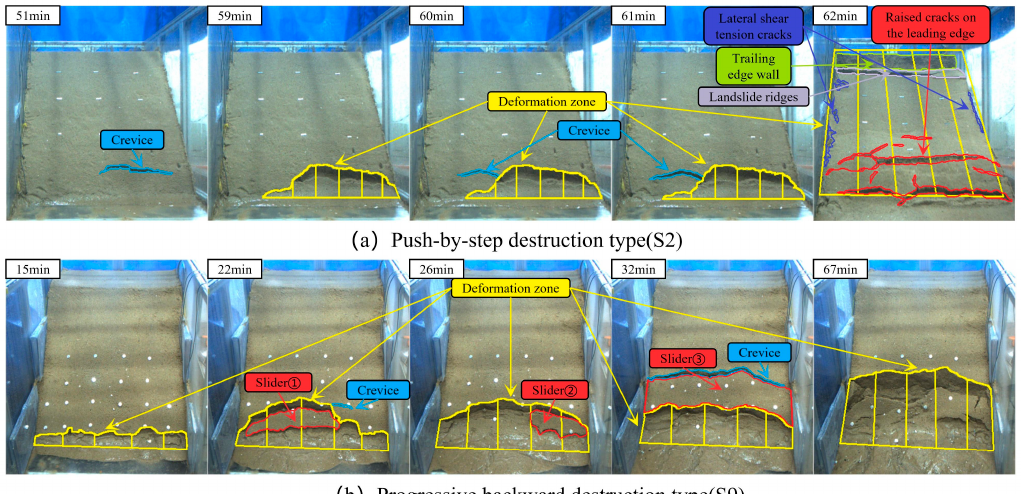
Figure 7. Types of spatial damage to landslides.